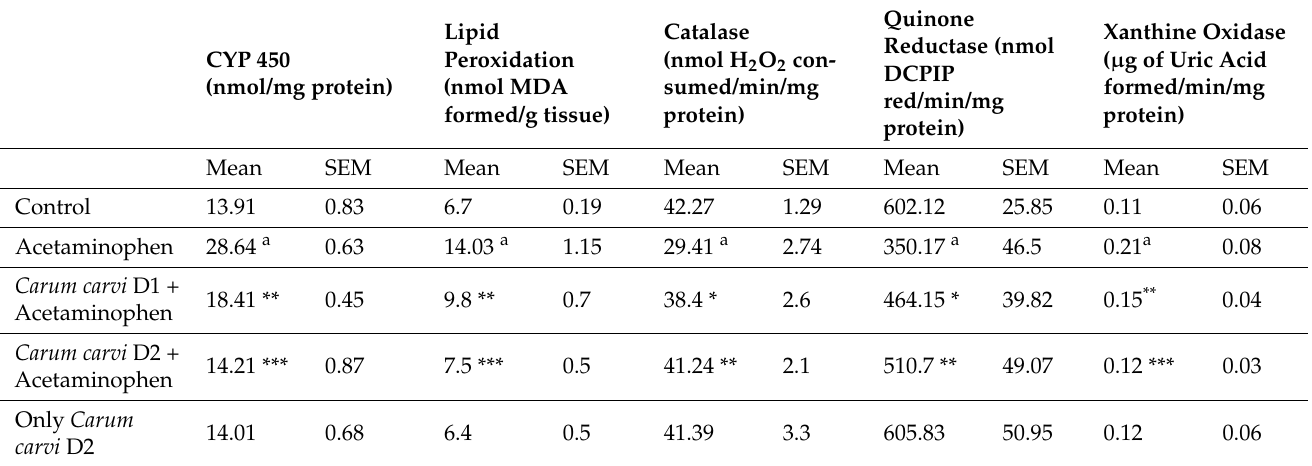
Table 2. Effect of Carum carvi treatment on acetaminophen-induced changes in biochemical parameters.